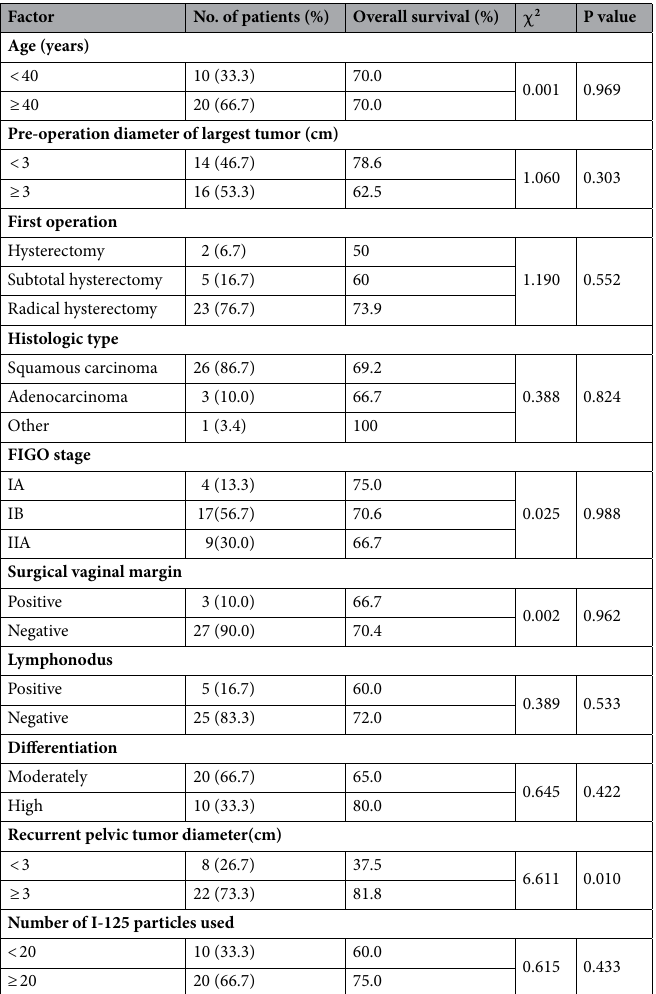
Table 4. Results of univariate Kaplan–Meier survival analysis with Log-Rank test for various prognostic factors.